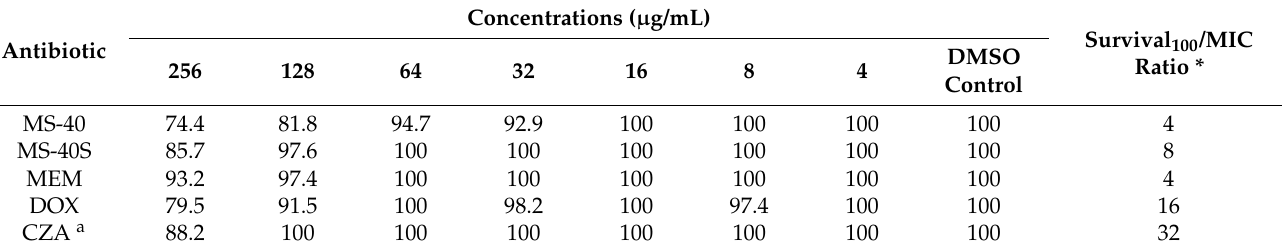
Table 4. Percent survival of C. elegans exposed to MS-40, MS-40S, and clinical antibiotics.